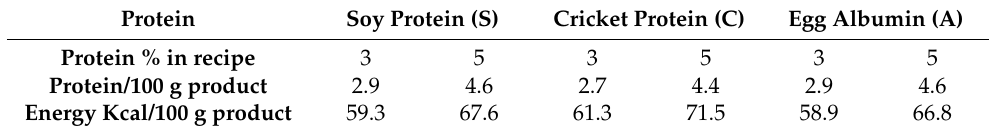
Table 2. Protein information. Protein Soy Protein